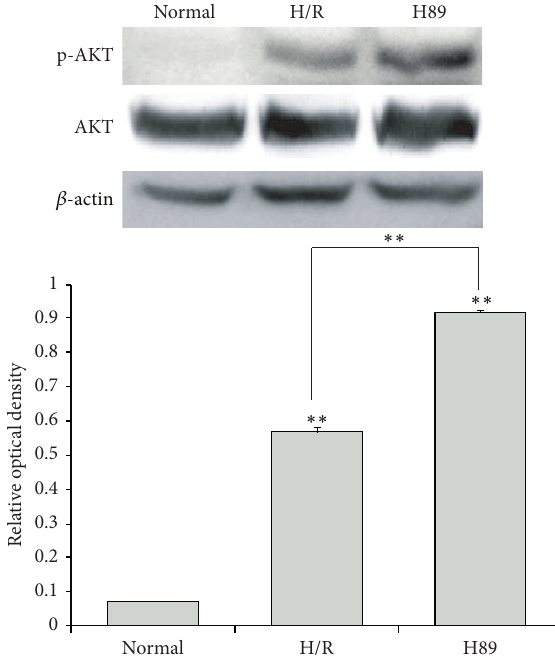
Figure 9: The measurement of AKT phosphorylation in Neuro2A cell against H/R injury. Western blotting experiments showed that the relative protein level of phosphorylation-AKT (p-AKT)/AKT significantlywasincreasedintheH89pretreatmentgroupcompared to the hypoxia and reperfusion group. 𝛽 -actin was used as an internal control. Data were expressed as mean ± S.E.M, and each experiment included 4 repeats per condition. Differences were considered significant at ∗∗ 𝑃 < 0.001 . Normal: the normal control group, H/R: 4 hr hypoxia and 18 hr reperfusion injury group, H89: 2 hr PKA inhibitor H89 treatment group before 4 hr hypoxia and 18hr reperfusion injury, and p-AKT: